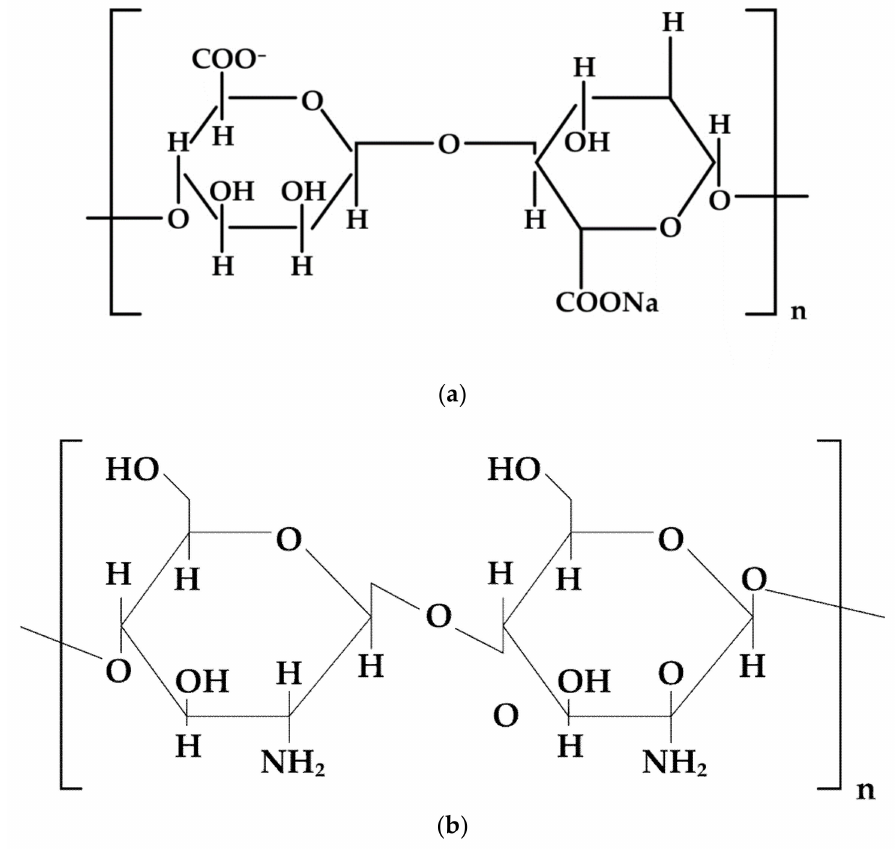
Figure 7. Schematic illustration of ( a ) sodium alginate, ( b ) chitosan chemical